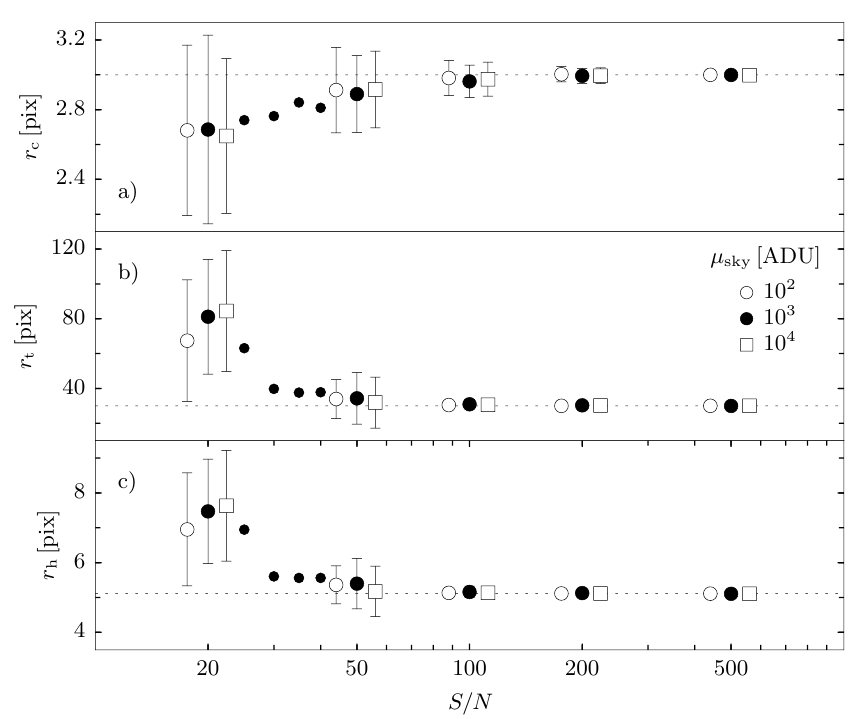
Fig. 5. Median and standard deviation of the recovered radii r c , r t , and r h of 100 clusters per model grid node as a function of signal to noise, S/N . For the same S/N , symbols indicate different sky background, µ sky = 10 2 (open circles), 10 3 (large filled circles), and 10 4 ADU (squares). Horizontal dashed lines show true parameter values. Additional simulations at intermediate values of S/N = 25, 30, 35, and 40 with µ sky = 10 3 ADU are shown by small filled